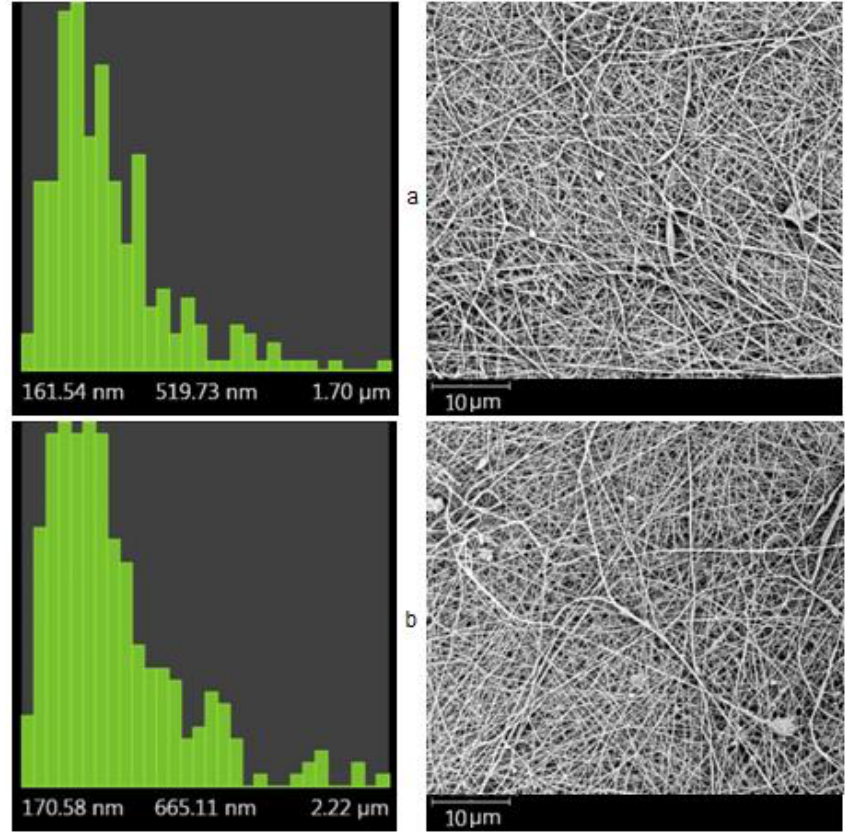
Figure 1. Distribution of the fiber diameter and the fiber morphology of the chitosan (CS) surface ( a ) and the hyaluronic acid (HA) surface ( b ) of the bilayer nonwoven material. Distribution parameters were calculated from three SEM images (a total of 250–300 measurements).